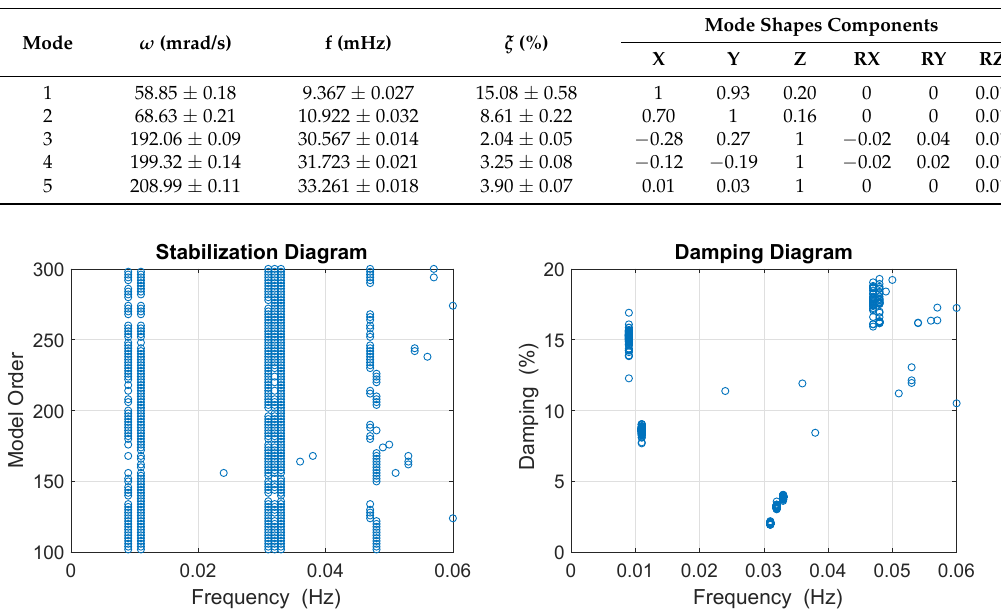
Table 7. Modal properties, including angular frequencies, natural frequencies, modal damping ratios, and 6 mode shape components obtained with the SSI-COV method, joined analysis of all datasets.